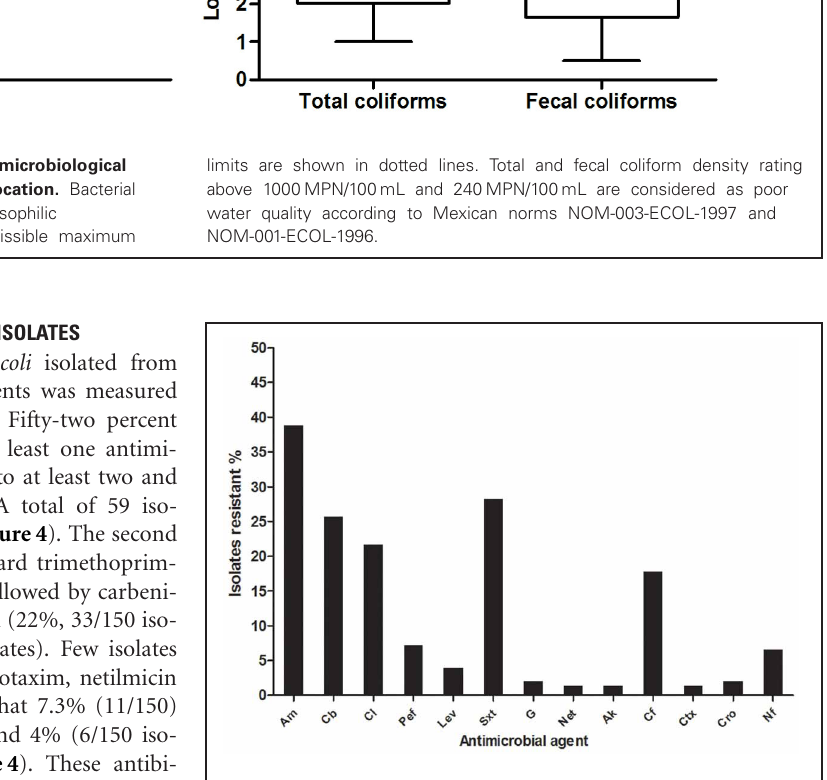
FIGURE 4 | Antimicrobial resistance (%) of E. coli isolated from San Pedro River. A total of 150 isolates were characterized by antimicrobial susceptibility assay. a Am, ampicillin; Cb, carbenicillin; Cl, chloramphenicol; Pef, pefloxacin; Lev, levofloxacin; Sxt,